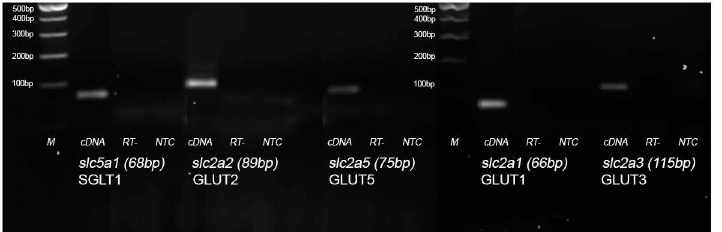
Fig 2. Identification of hexose transporter genes expressedin Caco-2/TC7 cells. RNA was isolated from Caco-2/TC7 cells grown for 21 days and convertedto cDNA. The presenceof SGLT1 (slc5a1), GLUT2 (slc2a2), GLUT5 (slc2a5), GLUT1 (slc2a1) and GLUT3 (slc2A3) transcripts was undertaken by PCR. (M) represents the molecularweight marker ladder. For each gene, (cDNA) representsa PCR amplification using Caco-2/TC7 cDNA as a template, (RT-) represents a PCR using template obtained from reverse transcriptase reactionwithout enzyme. (NTC) representsa PCR using no template.